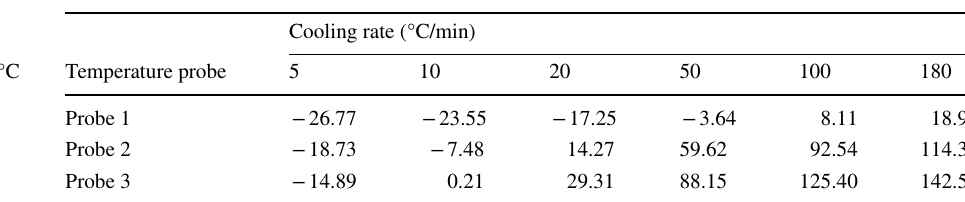
Cooling rate (°C/min)